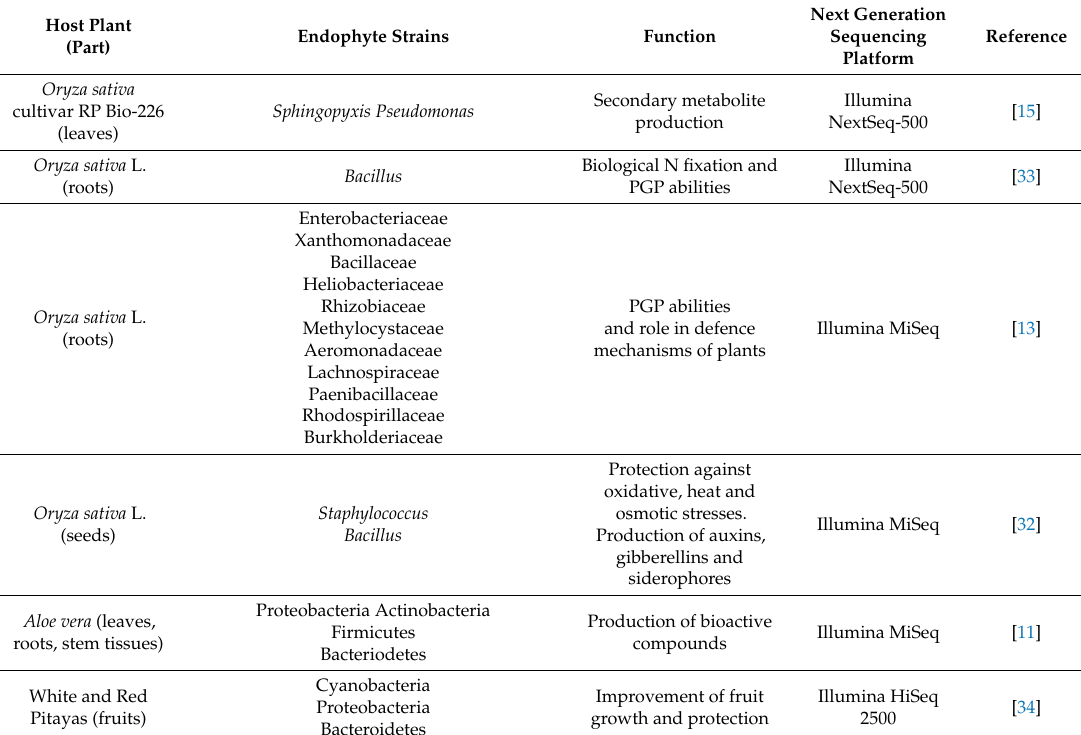
Table 1. Beneficial functions of metagenomically identified endophytes colonizing di ff erent parts of